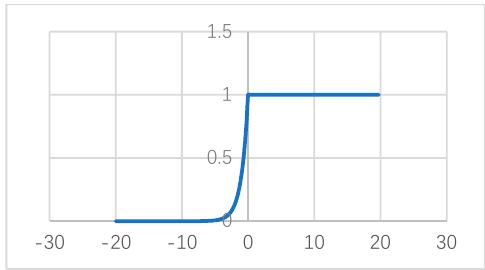
Figure 7. The customized activation function of the semantic gate. From the figure, it can be seen that when the x ≥ 0, the value of f(x) equals to 1, otherwise it equals to e x .